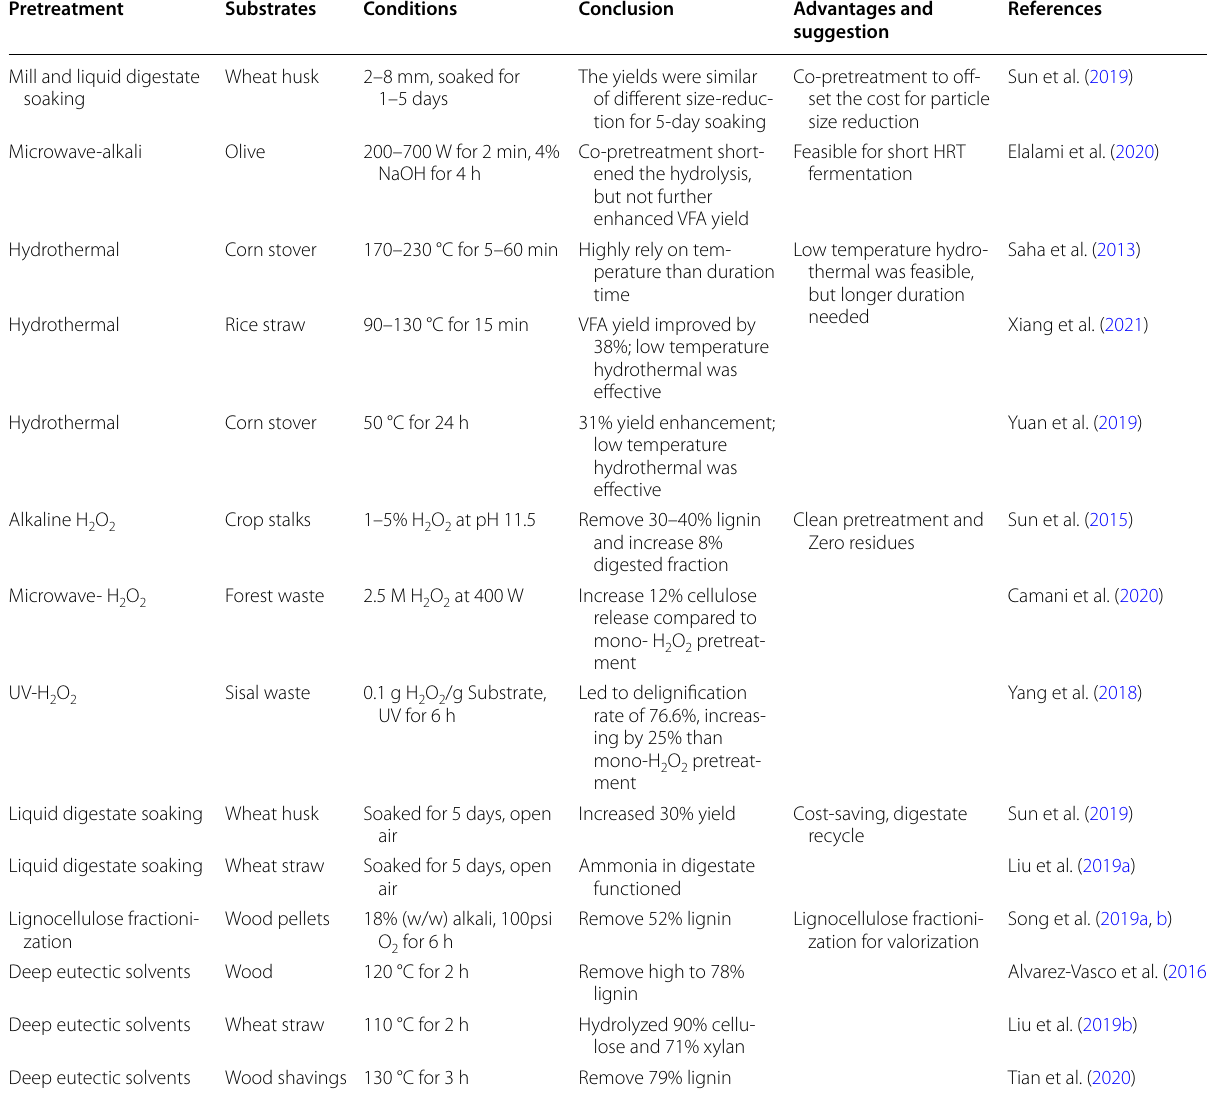
Table 3 Pretreatment of lignocellulosic biomass